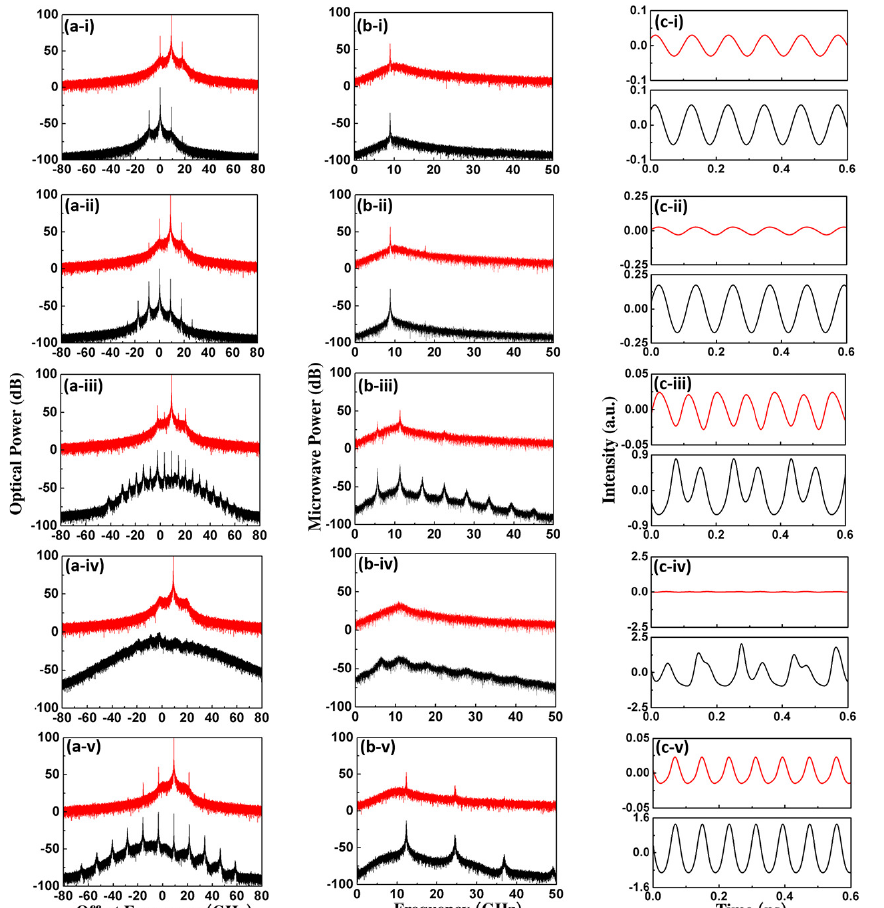
Figure 4. ( a ) Optical spectra, ( b ) microwave spectra, and ( c ) temporal evolutions of LD1 (red curve) and LD2 (black curve) for ( i ) ξ s and ( v ) ξ s = 0.055, respectively, when ξ s 12 the free-running oscillation frequency of LD2. The red curves in ( a , b ) are up-shifted by 100 dB for clear